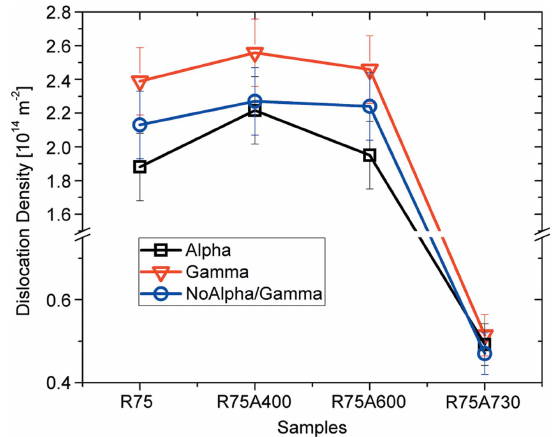
Figure 18 Dislocation densities for the cold-rolled and annealed samples. EBSD results show that the (cid:6) -fibre accumulates a greater number of dislocations for both the cold-rolled sample and the samples annealed at 400 (cid:6) C and 600 (cid:6) C. For the sample annealed at 730 (cid:6) C, the density of dislocations becomes homogeneous for all orientations. This is in agreement with the observations made from the Langford analysis from